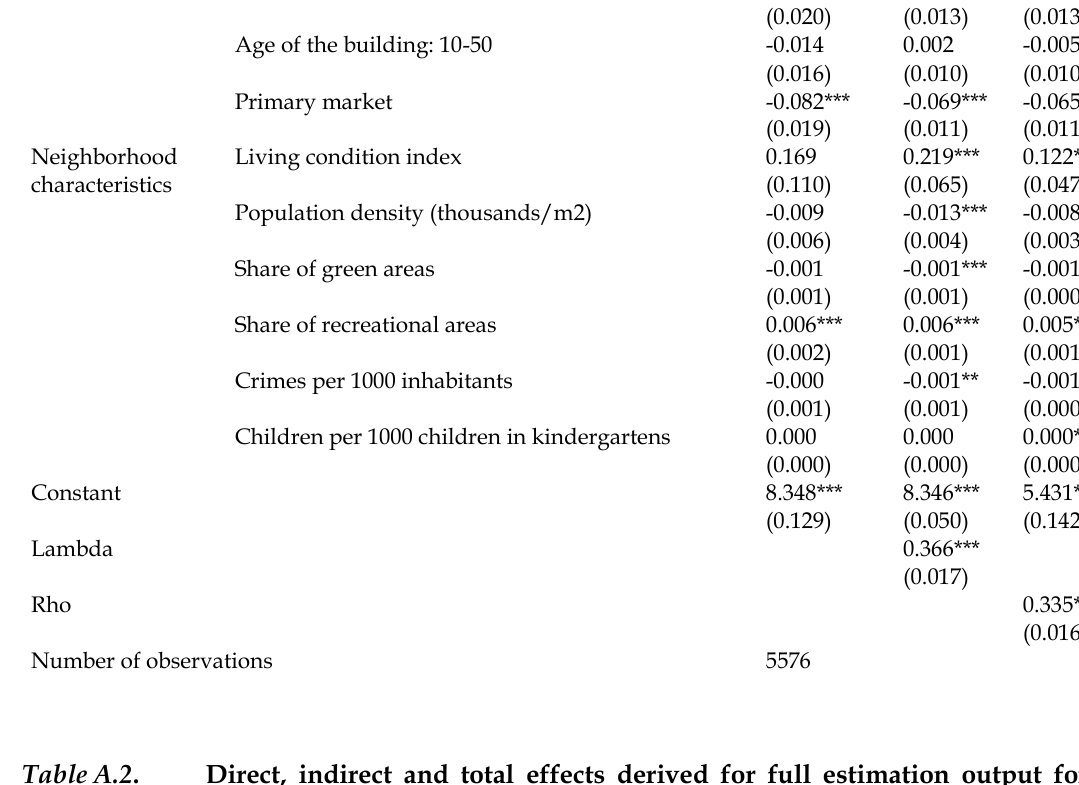
Table A.2 . Direct, indirect and total effects derived for full estimation output for SAR